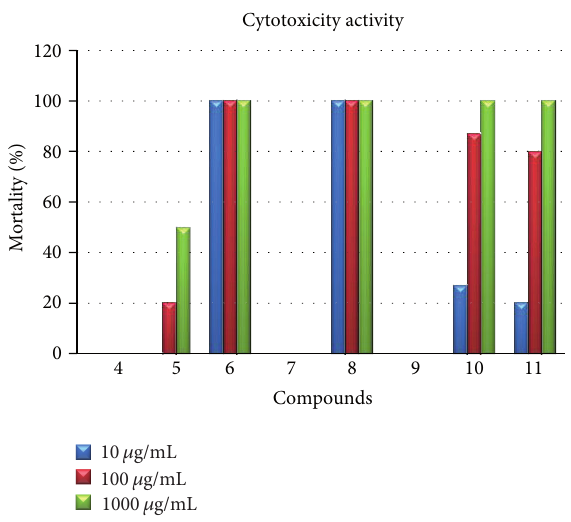
F 4: Cytotoxic activity of compounds 4–11